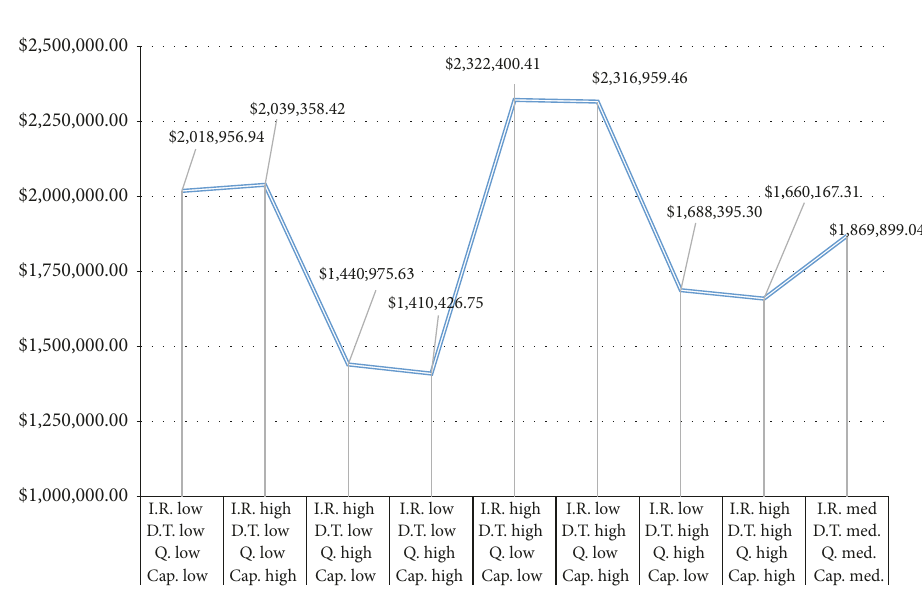
Figure 10: Total profit.